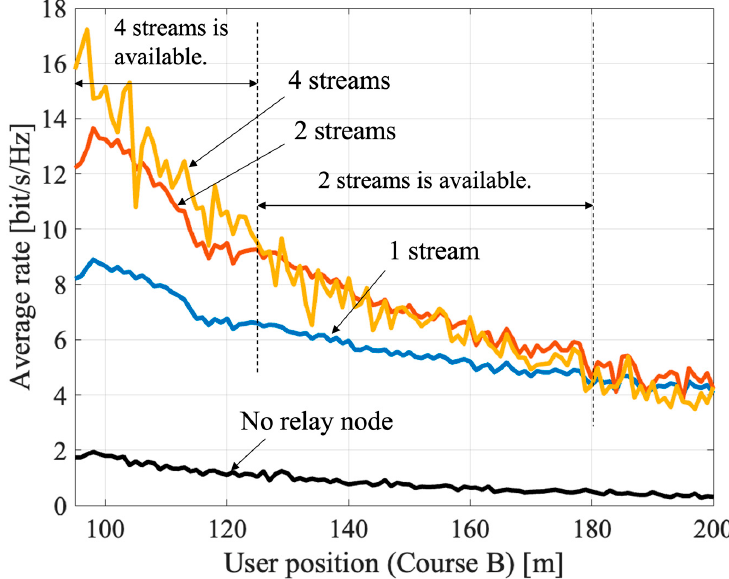
Figure 7. Average rate of massive relay MIMO with the proposed method in the course (b).